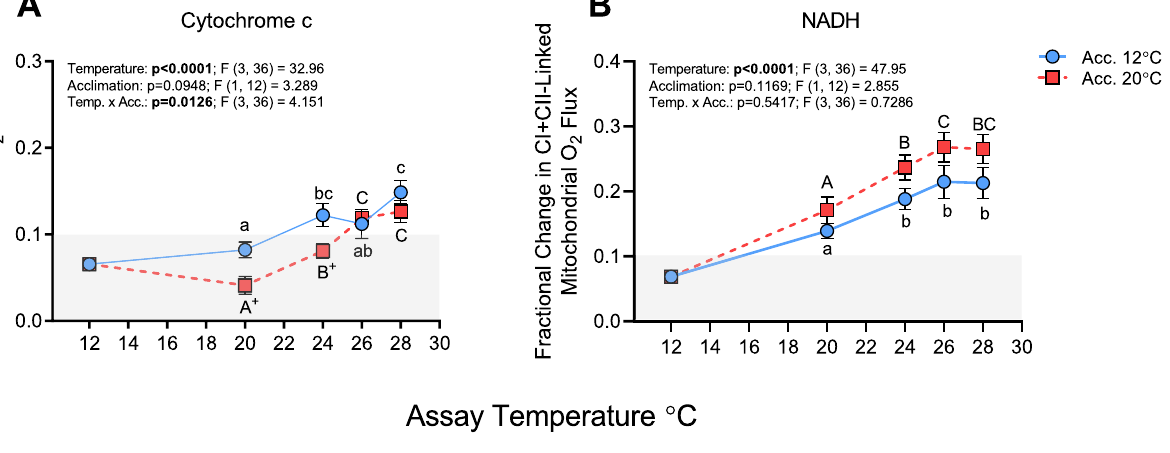
Figure 4. Outer and inner membrane integrity (measured as the fractional increase in respiration) in cardiac mitochondria from cold- (12 °C) and warm- (20 °C) acclimated salmon measured at 20, 24, 26 and 28 °C. Integrity of the outer ( A ) and inner ( B ) mitochondrial membranes were assessed by calculating the fractional increase in O 2 flux following the addition of cytochrome c and NADH, respectively, during oxidative respiration (OXPHOS with excess ADP) through complexes I + II (i.e., with glutamate, malate and succinate as substrates). Control values at 12 °C for mitochondria from cold- (12 °C) acclimated fish were added in the graphs to show that the fractional increase in O 2 flux following cytochrome c and NADH addition is normally below 0.1 (i.e., < 10%; N = 4; data not included in statistical analyses as the data were obtained using fish from a different trial). The gray area represents the range of values < 0.1. An asterisk (*) indicates a significant (P < 0.05) difference between acclimation groups within an assay temperature, whereas a plus sign (+) indicates a difference at P = 0.065, and letters (a, A) indicate a significant difference between assay temperatures within an acclimation group. Values are means ± s.e.m., N = 7 per group.